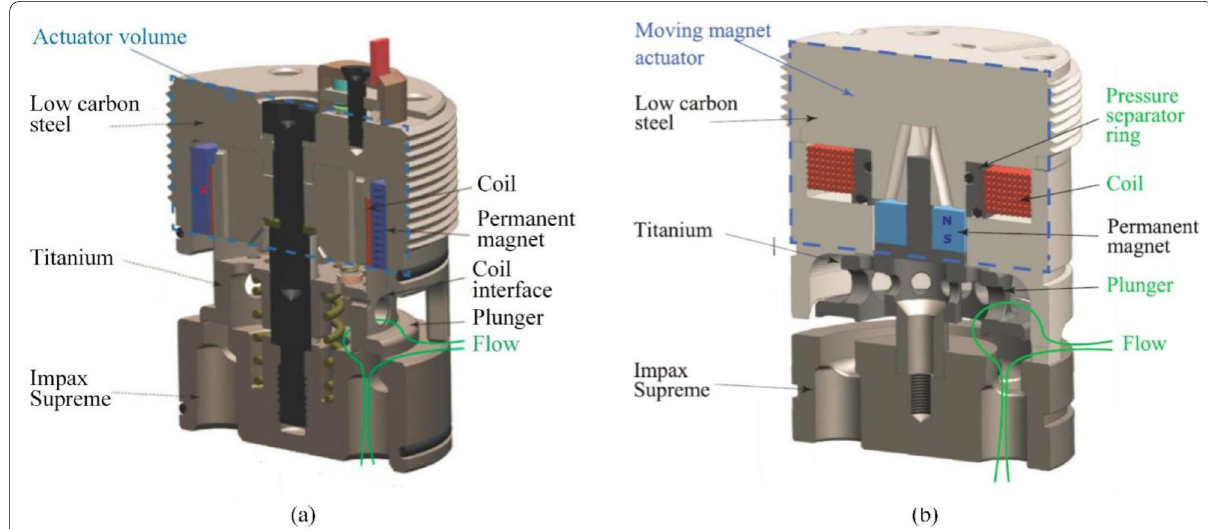
Figure 7 Seat valves: a moving-coil actuated valve developed by Noergaard et al., b moving-magnet actuated valve designed by Madsen et al.